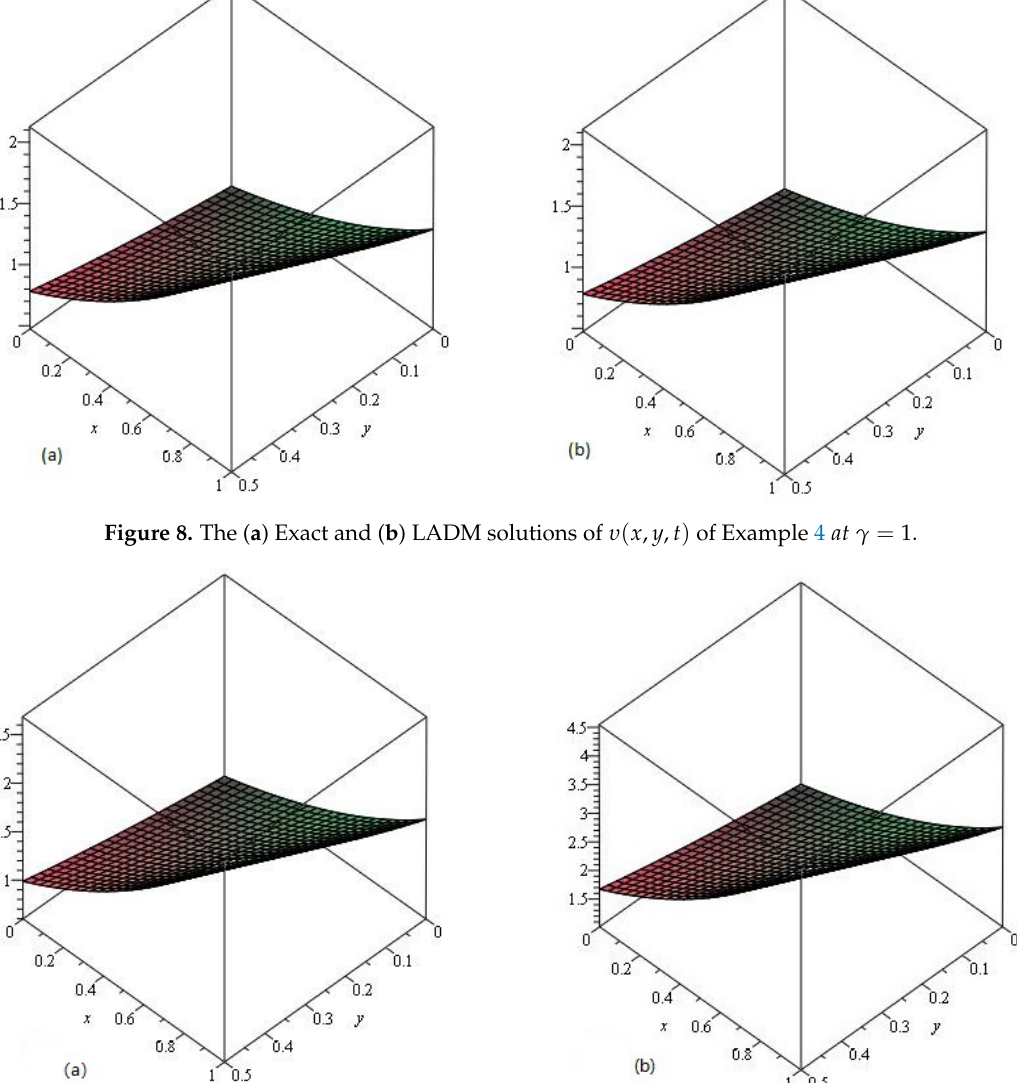
Figure 9. The LADM solution of υ ( x , y , t ) of Example 4.4 at ( a ) γ = 0.75 and ( b ) at γ =